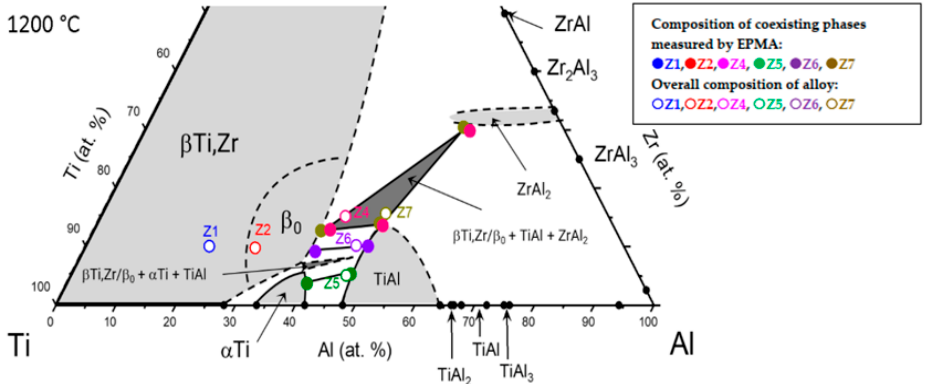
Figure 7. Partial Ti—Al—Zr isothermal section of the at 1200.